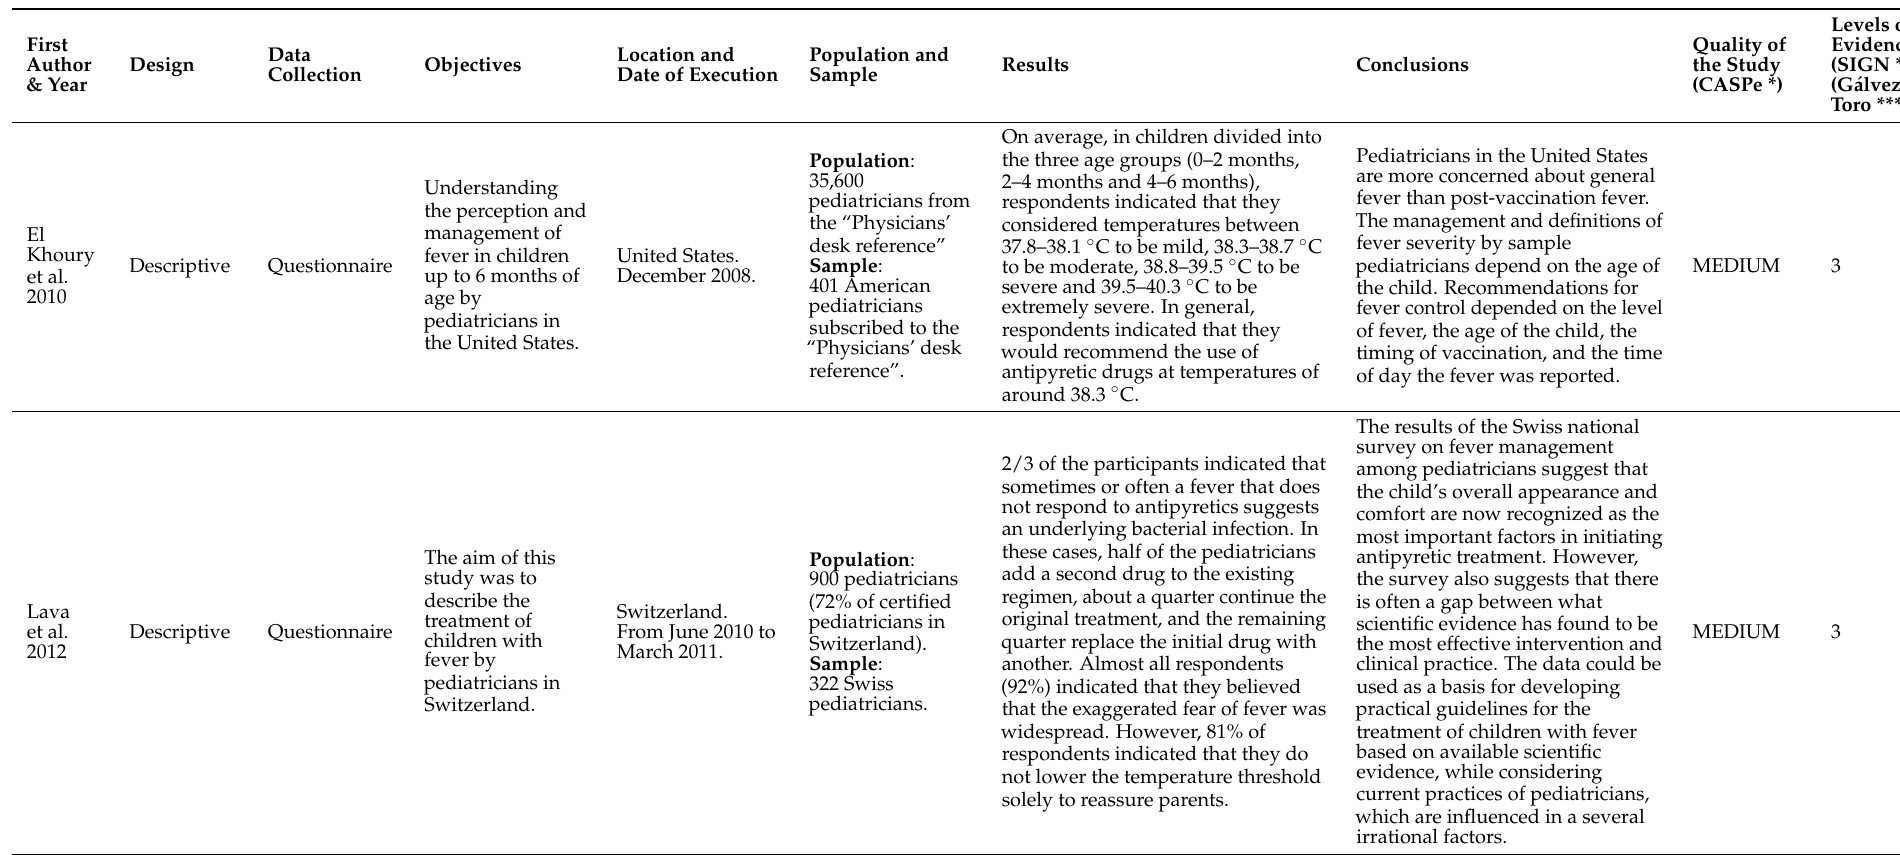
Table 1. Quality of studies measured by “Critical Appraisal Skills Programme España” (CASPe) *. Levels of evidence used: “Scottish Intercollegiate Guidelines Network” SIGN